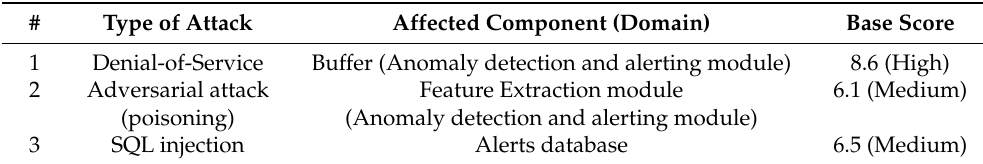
Table 3. Exploitation probability scores for the basic